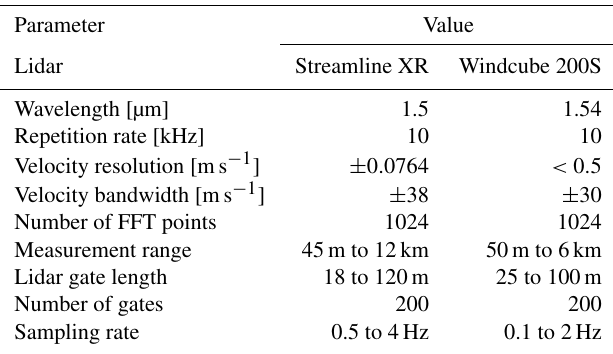
Table 1. Technical specifications of the pulsed scanning Doppler wind lidars used for this work, namely a Streamline XR by Halo Photonics and a Windcube 200S by